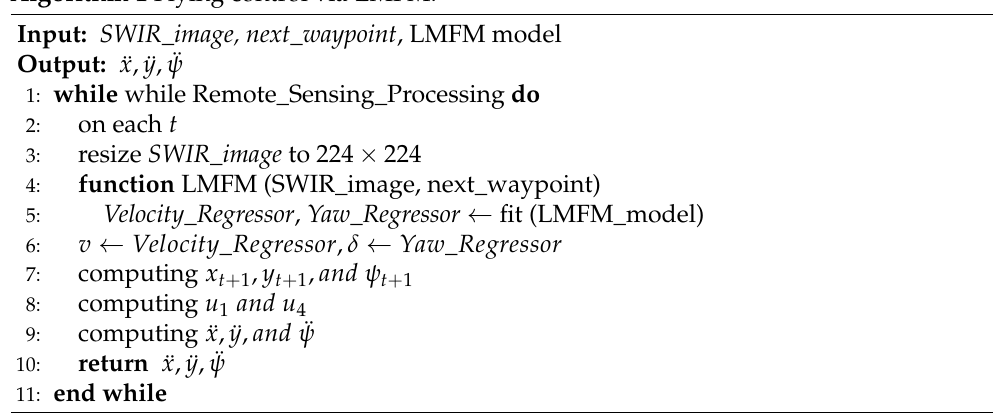
Algorithm 1 Flying control via